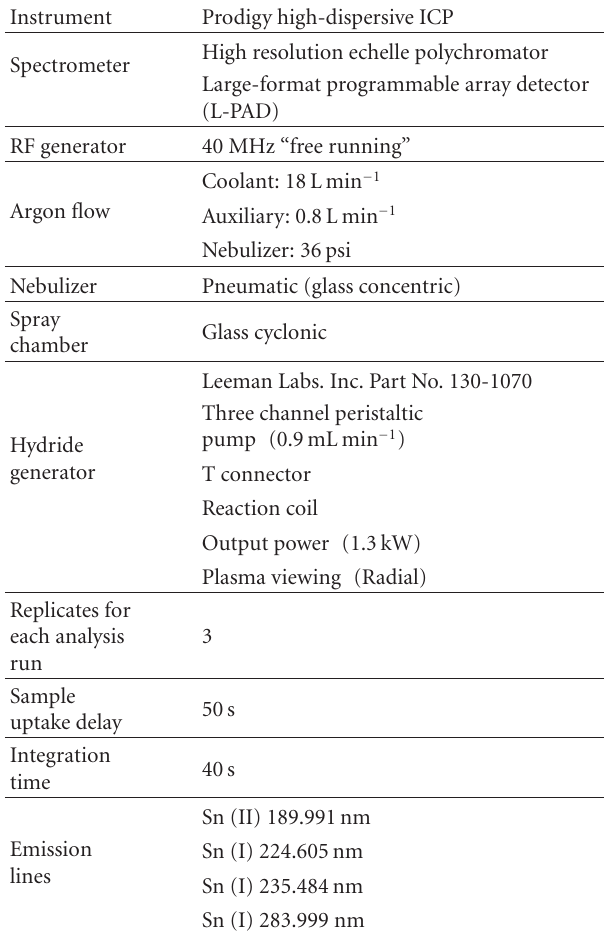
Table 1: ICP-AES operating conditions.